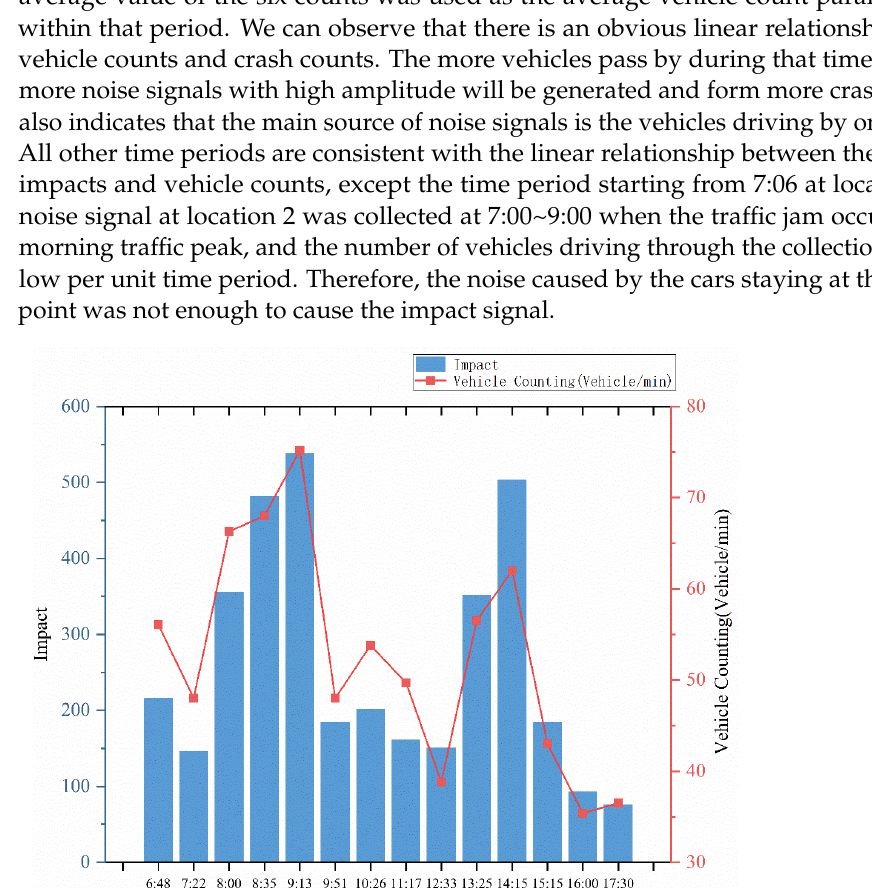
Figure 18. Noise signal impact-vehicle counting correlation diagram at position 2 of Yellow River Bridge.